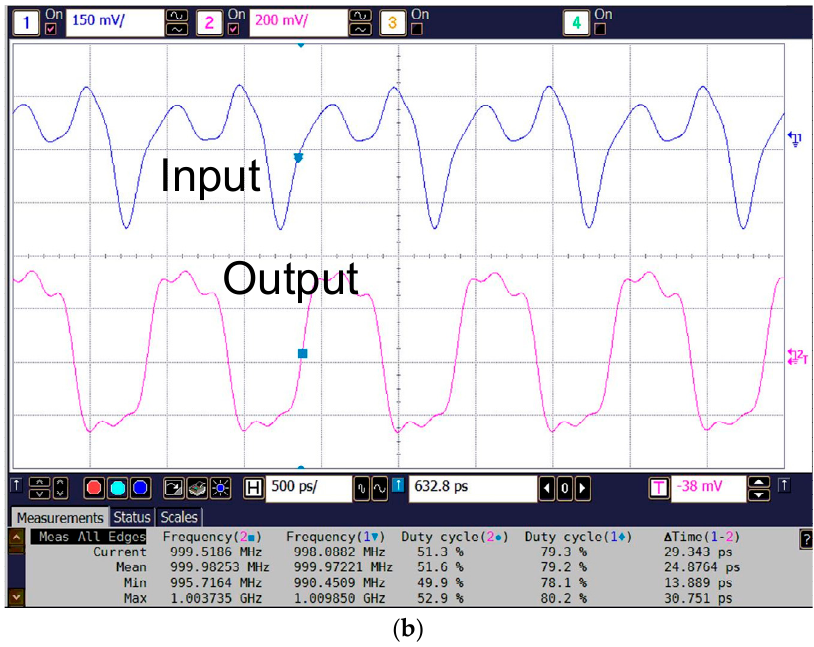
Figure 9. Measured result with input duty at 1 GHz ( a ) 20% ( b ) 80%.